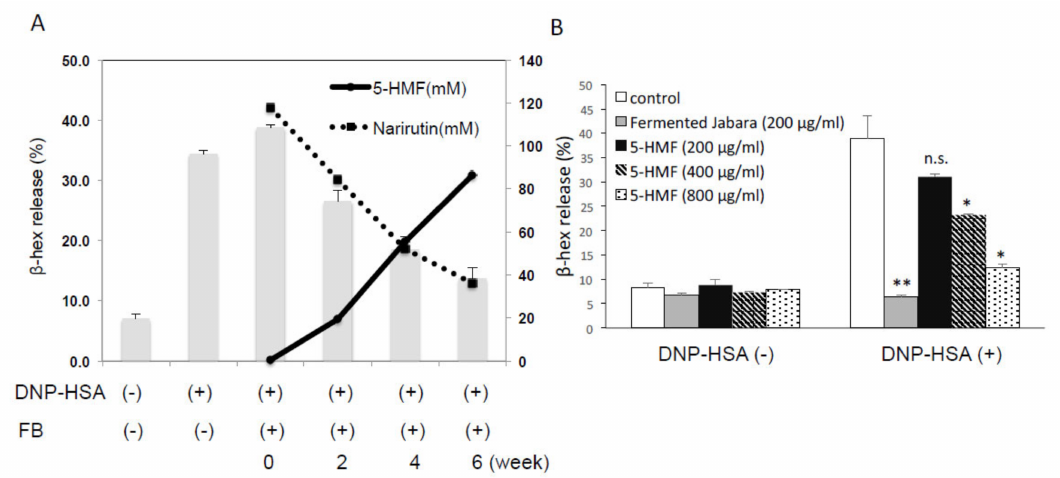
Figure 4. ( A ) Inhibitory e ff ect of the DMSO extract of fermented Jabara (FB) on β -hex release from mast cells. IgE-sensitized mast cells (1.0 × 10 5 cells / well) were preincubated with each extract (200 ug / mL) at 37 ◦ C for 15 min prior to 30 min stimulation with DNP-HSA. Data are presented as mean (SD). Solid and dashed lines: Amount of 5-HMF (mM) and Narirutin (mM) in Jabara, respectively, determined on di ff erent days of fermentation by HPLC analysis. ( B ) Inhibitory e ff ect of 5-HMF on β -hex release from mast cells. IgE-sensitized mast cells (1.0 × 10 5 cells / well) were preincubated with each extract at 37 ◦ C for 15 min prior to 30 min stimulation with DNP-HSA. Results represent one trial. At least three additional trials show similar results. Data are presented as mean (SD). * p < 0.05, ** p < 0.01, two-tailed Student’s t -test. n.s., not